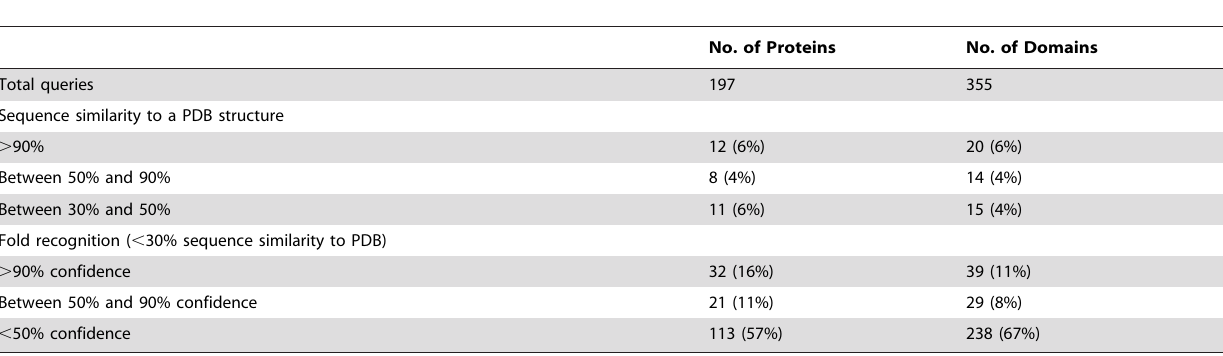
Table 2. Summary statistics for template-based structure prediction of the proteins encoded by the variola (smallpox) genome using the pipeline.